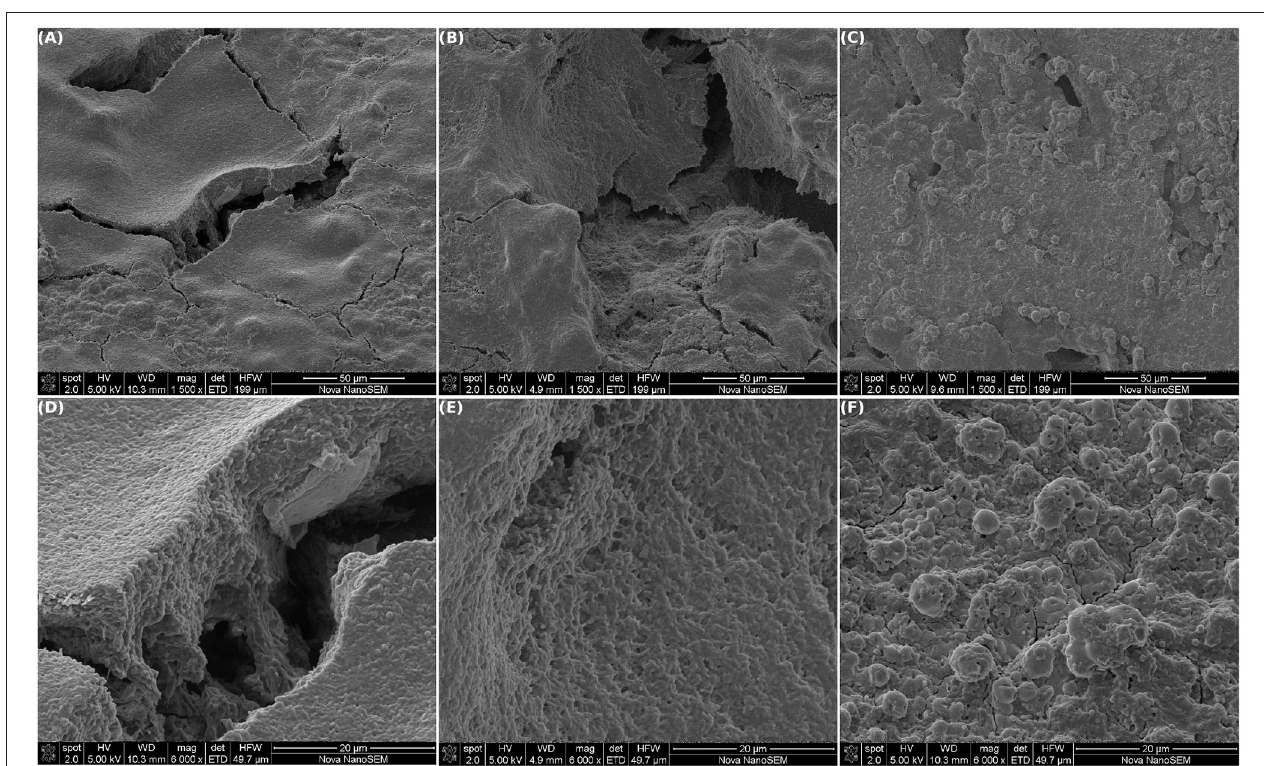
FIGURE 9 | Scanning electron microscopy of one of the two working electrodes of a MEC inoculated with the selected community. The WEs (graphite) were polarized at +480 mV vs. Ag/AgCl. The MEC was operated at 30 ◦ C in anaerobiosis. At 312 h of operation the second WE was removed. Different areas of the graphite are shown at low (A–C) and high magnification (D–F)